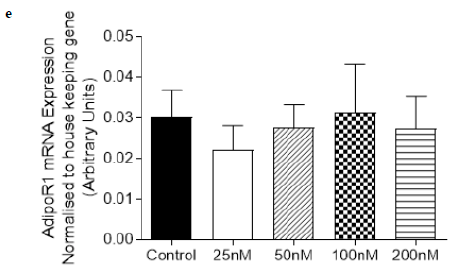
Figure 6. The abundance of mRNA expressed for markers involved in adiponectin signalling and oxidative capacity in human primary rectus abdominus -derived myotubes obtained from individuals that are obese and have type two diabetes mellitus treated for 24 h with O-1918 (25–200 nM). mRNA expression was normalised to housekeeping gene Cyclophilin and grouped data is reported as mean (arbitrary units) ± SEM. ( a ) Nuclear Factor of Activated T-Cells calcineurin dependent 1 (NFATc1); ( b ) Peroxisome proliferator-activated receptor gamma co activator 1-alpha (PGC1 α ); ( c ) Adaptor protein containing pleckstrin homology domain, phosphotyrosine binding domain and leucine zipper motif 1 (APPL1); ( d ) Adaptor protein containing pleckstrin homology domain, phosphotyrosine binding domain and leucine zipper motif 2 (APPL2); ( e ) Adiponectin Receptor 1 (AdipoR1).